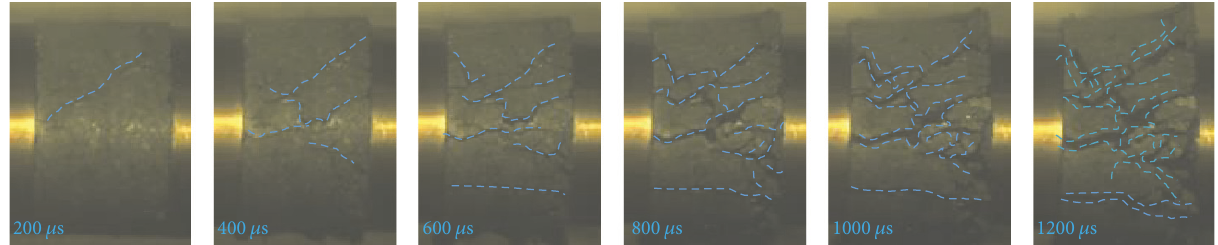
Figure 12: High-speed photos of natural specimen (B2) in dynamic failure processing.